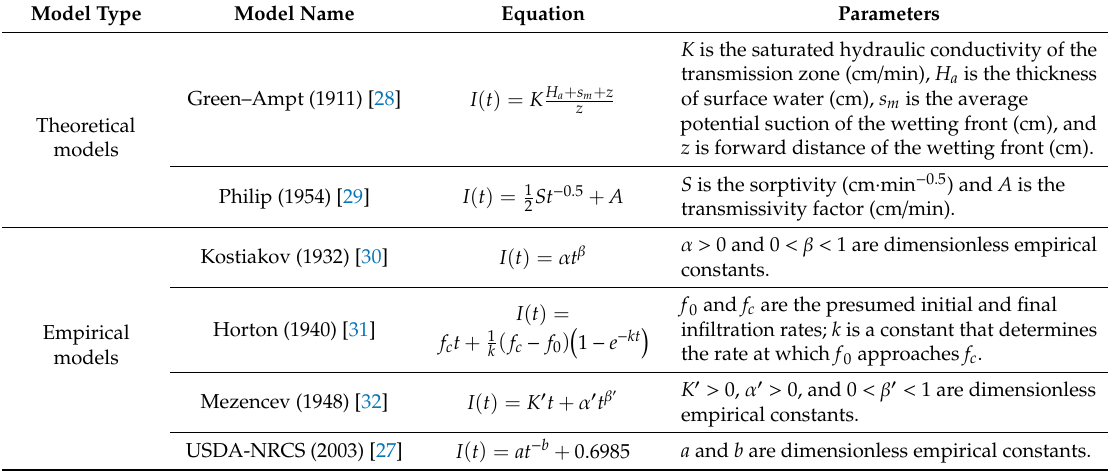
Table 2. Approximate theory-based and empirical infiltration